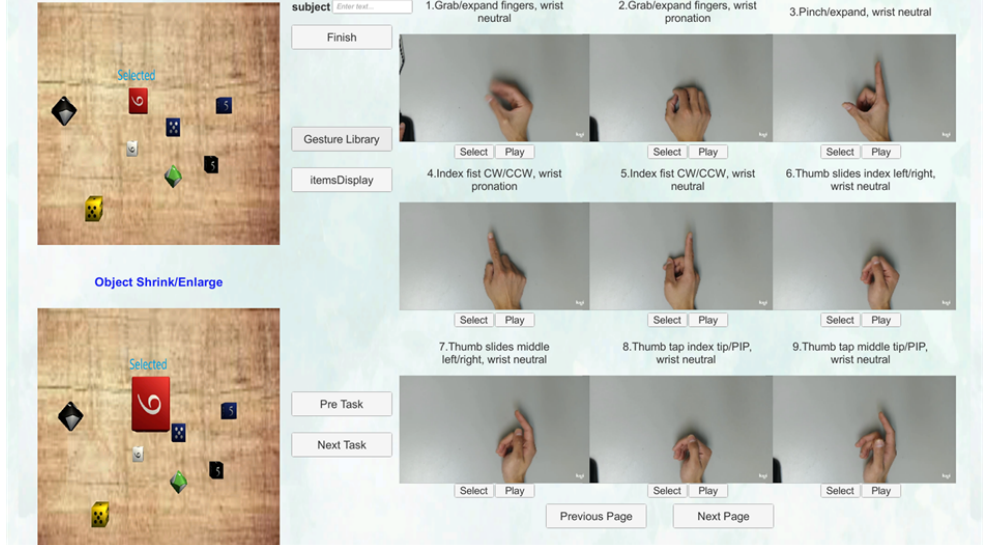
Figure 2. Interface for training participants on the command (task) and all the designed microgestures displayed on the computer